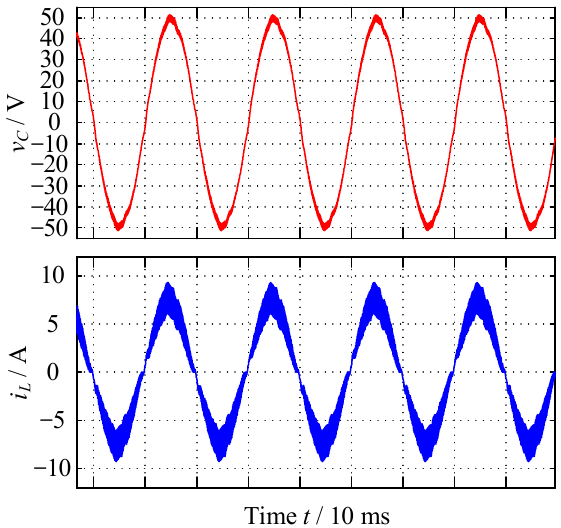
Figure 7. Simulation results of the proposed buck–boost inverter working as buck-type inverter.